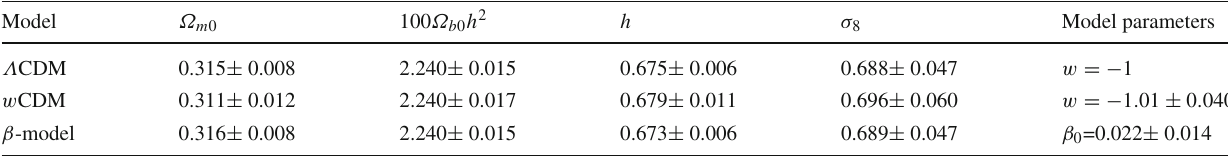
denotes the χ 2 best-fit bf